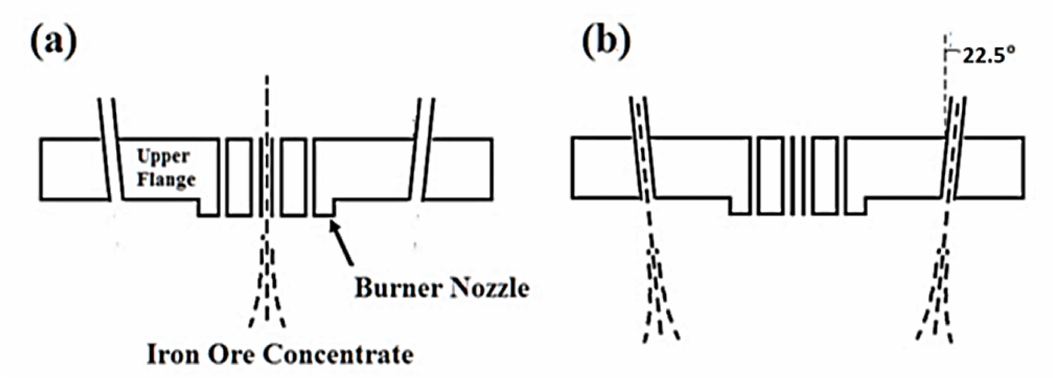
Figure 7. Powder feeding modes: ( a ) Burner feeding port. ( b ) Two Side-Feeding ports. (The figure is adapted from Sohn et al.